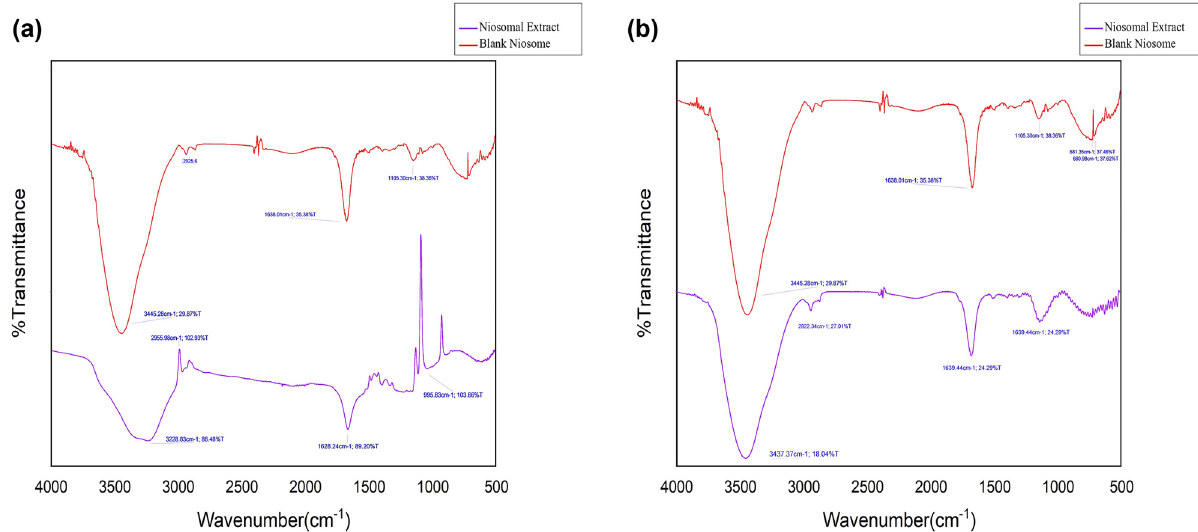
Figure 5: FTIR spectra of ( a ) Nio - GGE and ( b ) Nio -